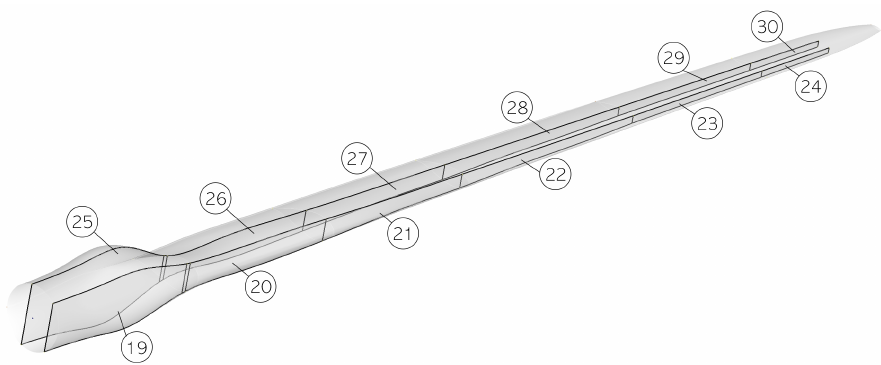
Figure 4. Blade’s spars regions is divided in six, from 19–30, symmetric regions containing a different composite layup.